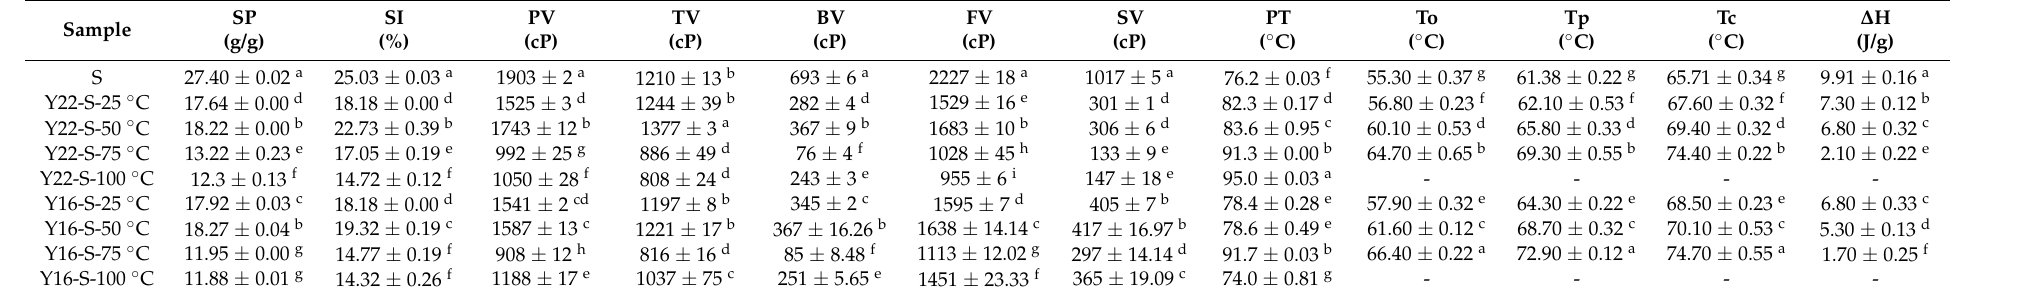
Results are presented as means ± SD. Values in the same column with different letters indicate significant differences ( p < 0.05). S, starch suspension prepared with 3.0 g (dry basis) of starch and 25 mL of distilled water. Y22 and Y16, glutens from weak (Yangmai 22) and medium (Yangmai 16) gluten wheats. The suspensions prepared with Y16 (0.5 g) and S (3 g) mixture with 25 mL distilled water and heated at 25, 50, 75, and 100 ◦ C were designated as Y16-S-25 ◦ C/50 ◦ C/75 ◦ C/100 ◦ C, Y22 (0.5 g) and S (3 g) mixtures at 25, 50, 75 and 100 ◦ C were designated as Y22-S-25 ◦ C/50 ◦ C/75 ◦ C/100 ◦ C, respectively. SP, swelling power; SI, solubility; PV, peak viscosity; TV, trough viscosity; BV, breakdown viscosity; FV, final viscosity; SV, setback viscosity; PT, pasting temperature. To, Tp, Tc, and ∆ H represent the onset temperature, peak temperature, conclusion temperature, and